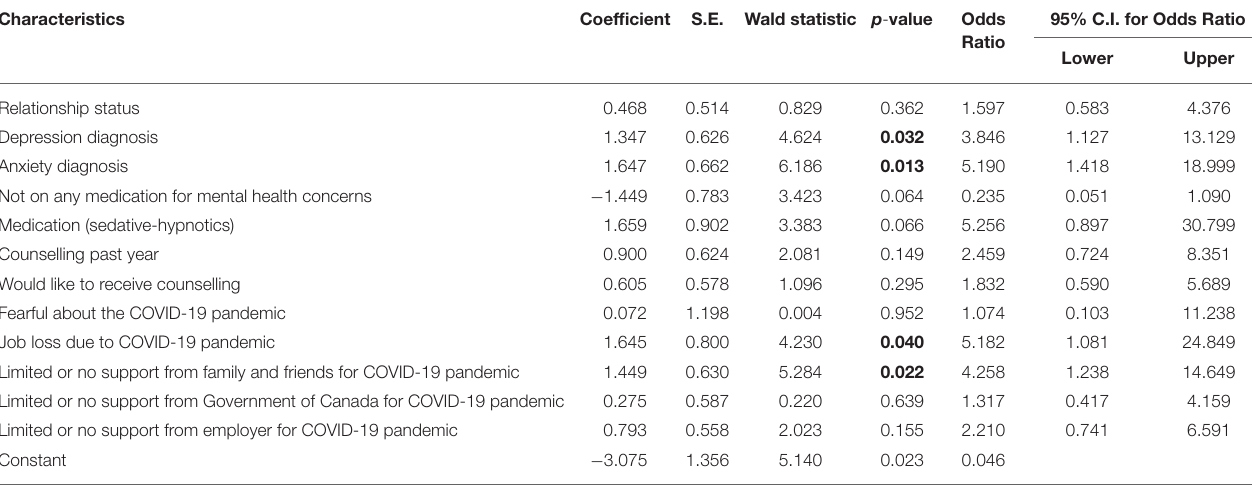
TABLE 3 | Logistic regression model for respondents’ likelihood to present with probable PTSD.